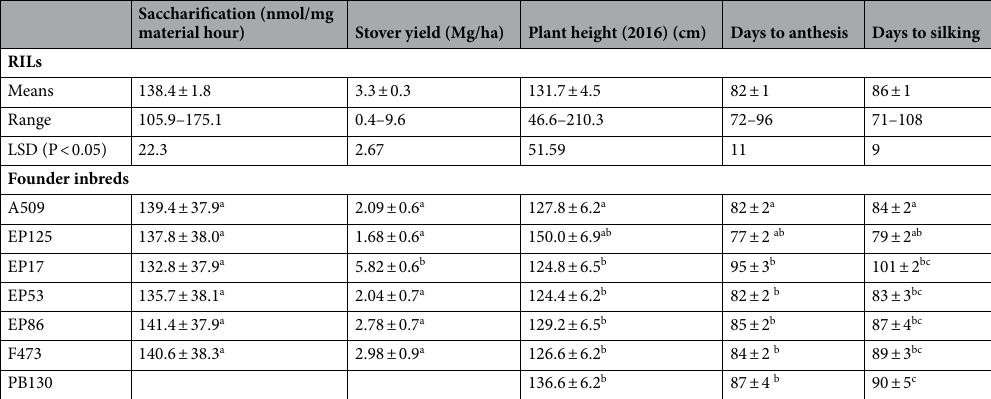
Table 1. Average and range values for saccharification efficiency, stover yield and agronomic traits in RILs and parent lines of the MAGIC population. 1 Values followed by the same letter within the same column are not significantly different (P >